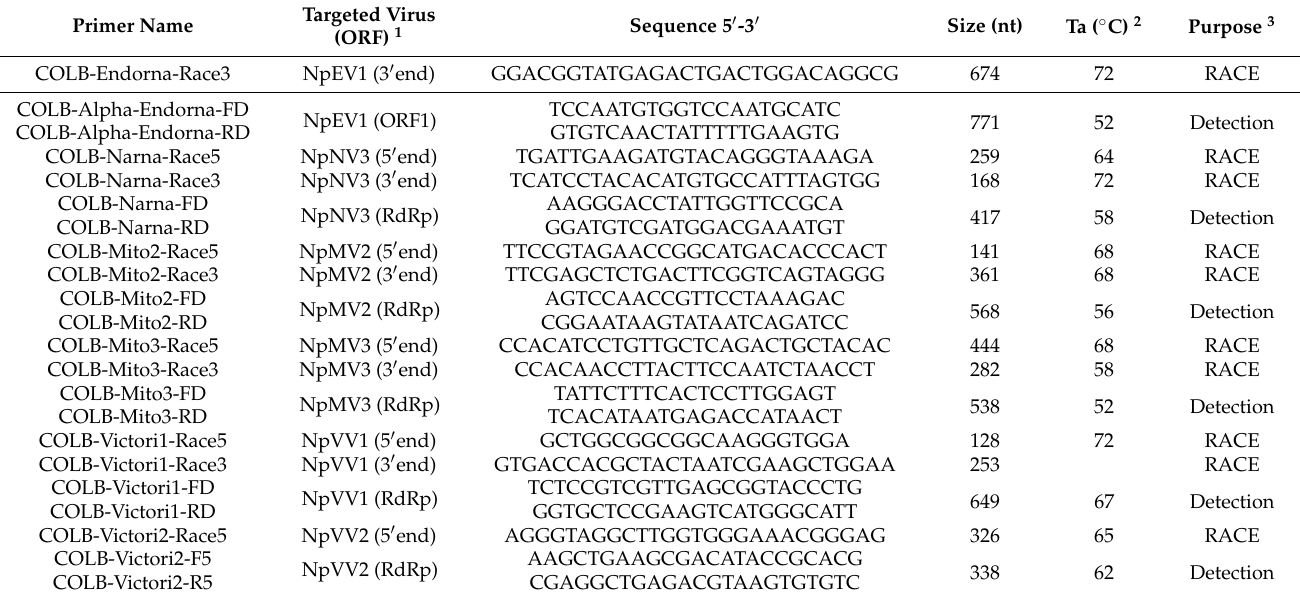
Table 1. Primers used in the